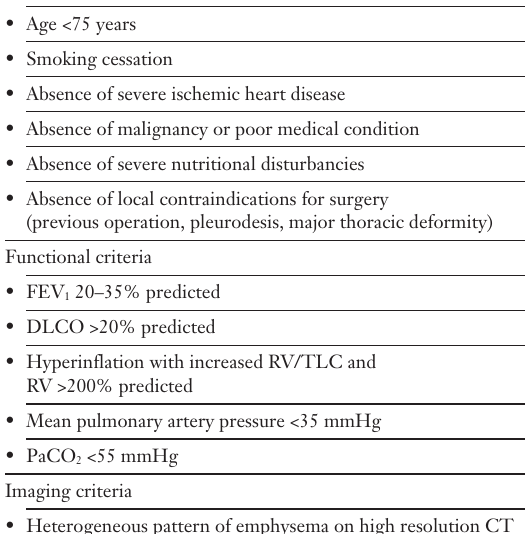
Selection criteria for